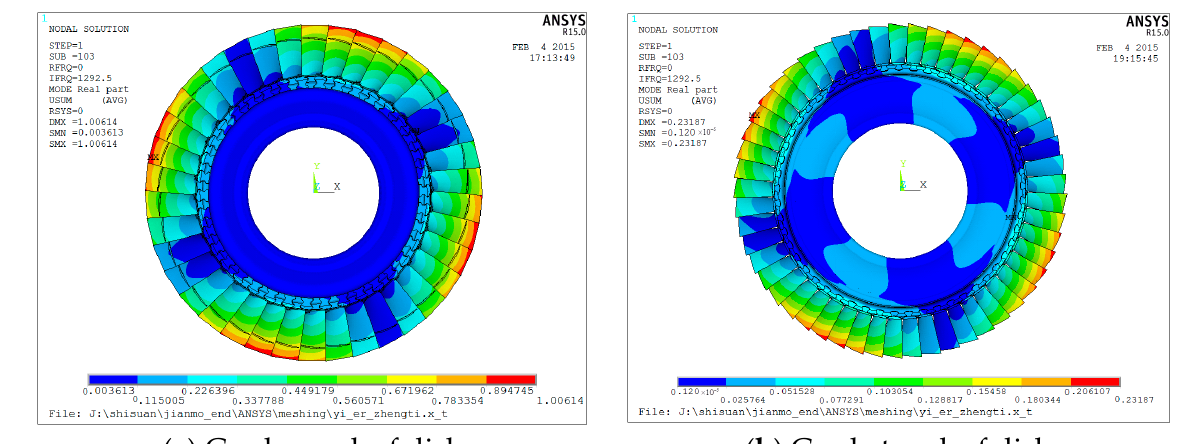
( c ) Second-stage bladed disk Figure 29. Coupled vibration at a natural frequency of 1730.44 Hz. According to the modal and mode shape analysis of the two-stage bladed disk cou- pled system, in the low-order mode, the first-order bending vibration of the first-order blade and the second-order blade is firstly manifested. With the increase in the modal order, the coupled vibration of the blade and the wheel, the twisted vibration of the blade, and the coupled vibration between the two stages of the bladed disk appear. In addition, it can be found that the vibration of the two-stage bladed disk will appear at the same frequency with the same pitch diameter. However, in most two-stage coupled bladed disks, the mode pattern cannot be seen directly. This is because the vibration of the first- stage bladed disk is dominant, while the vibration of the other stage is relatively small. For the order with obvious inter-stage coupled vibration of the two-stage bladed disk system, the maximum vibration displacements of the first-stage bladed disk system and the second-stage bladed disk system are shown in Table 10. Figures 30 – 35 show the inter- stage coupled modes. Table 10. Maximum displacement and ratio of the vibration of the Stage 1 and Stage 2 bladed disk systems. Order Num- ber